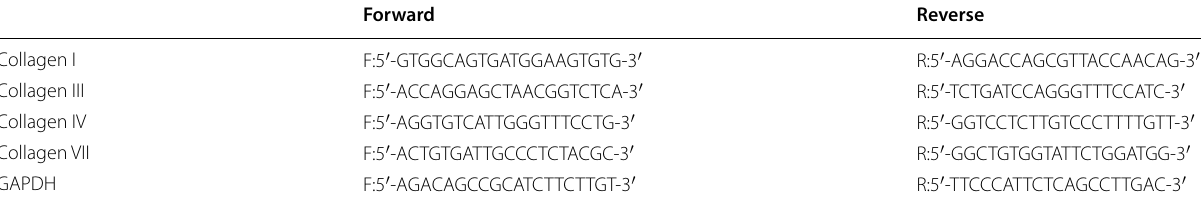
Table 2 Primers for RT-qPCR Analysis